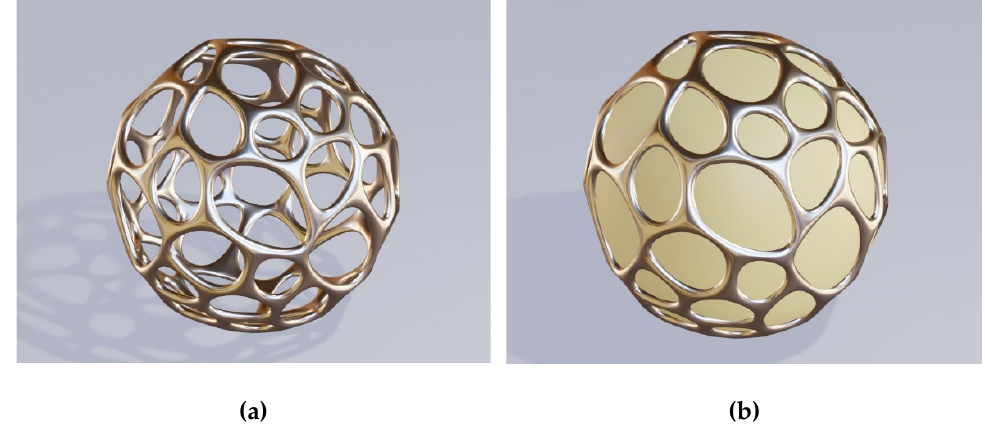
Figure 4. Holes designed to follow Voronoi pattern; ( a ) the core of the sphere with Voronoi openings is hollow; ( b ) the core is a solid lossless dielectric sphere.